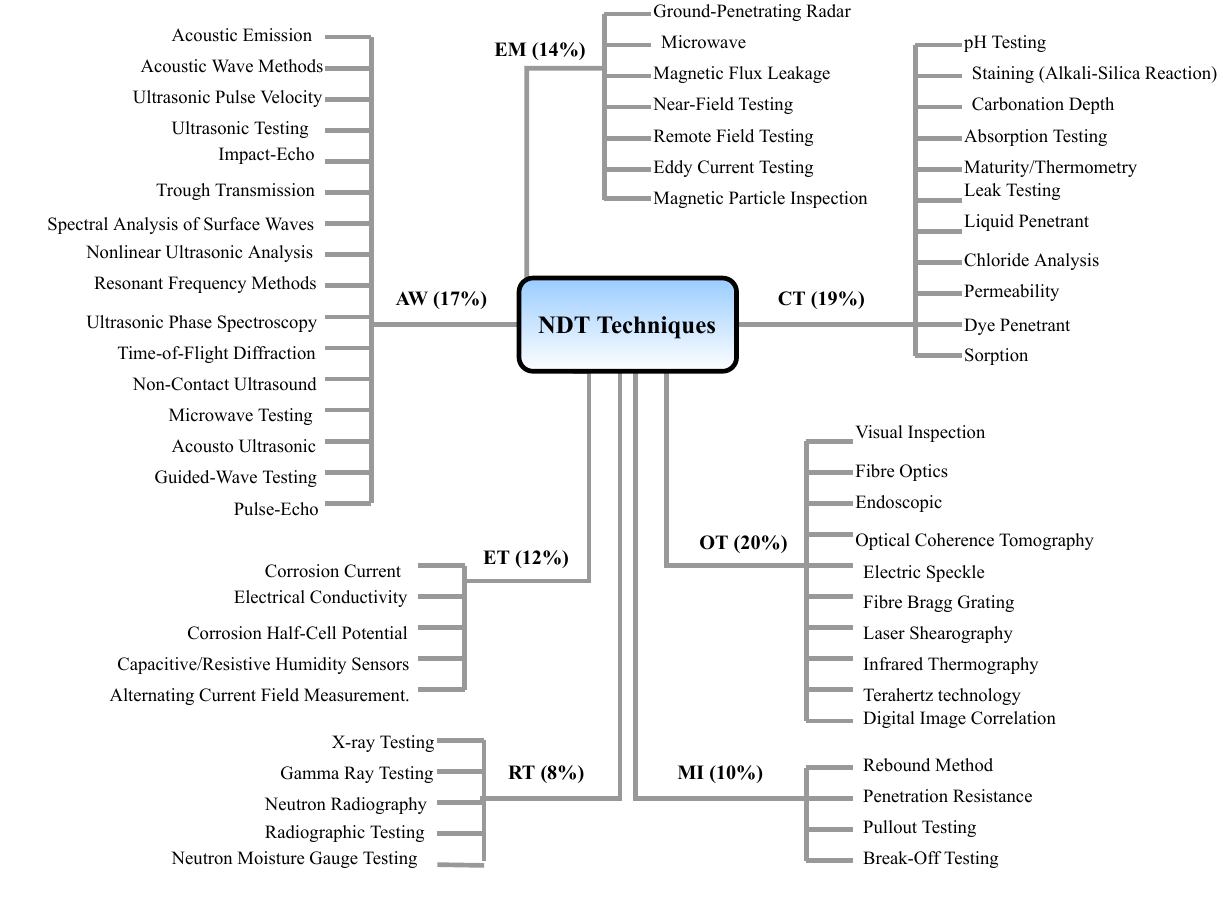
Figure 3. Categories of NDT techniques. Table 6. Common NDT technologies, inspection types, and probe styles used for